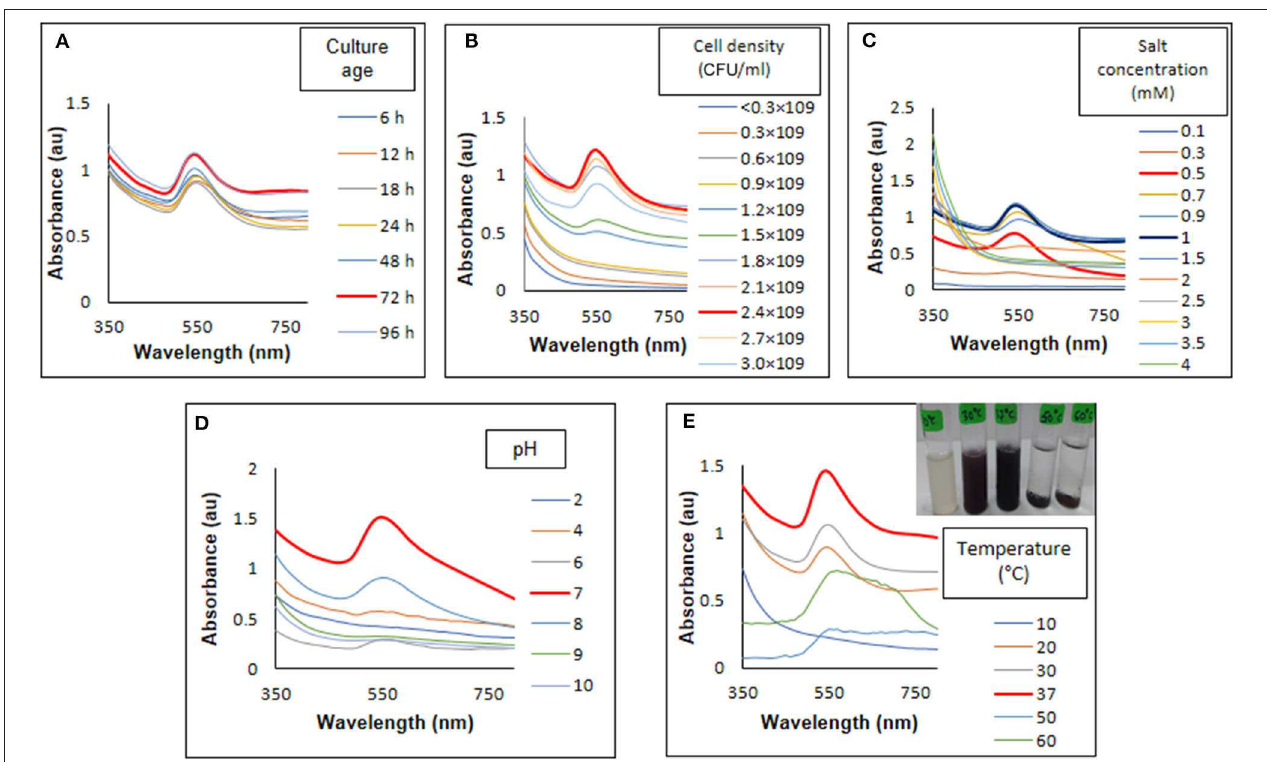
FIGURE 2 | Optimization of physicochemical parameter for synthesis of AuNPs. (A) Culture age, (B) cell density, (C) salt concentration, (D) pH, and (E)